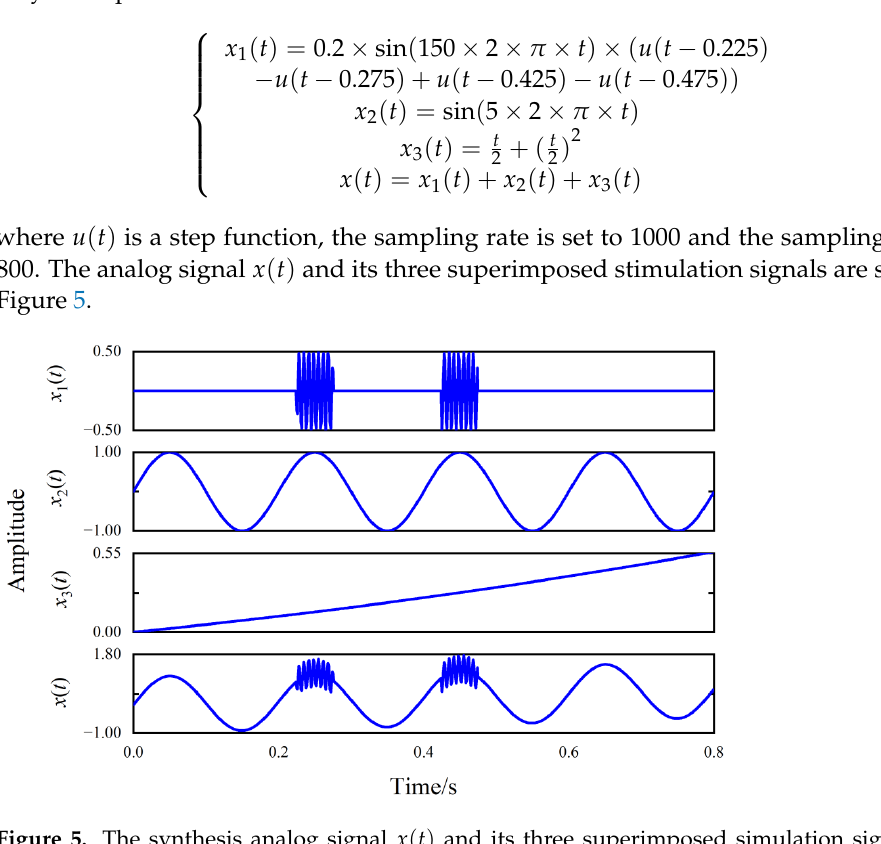
Figure 5. The synthesis analog signal x ( t ) and its three superimposed simulation signals x 1 ( t ), x 2 ( t ), x 3 ( t